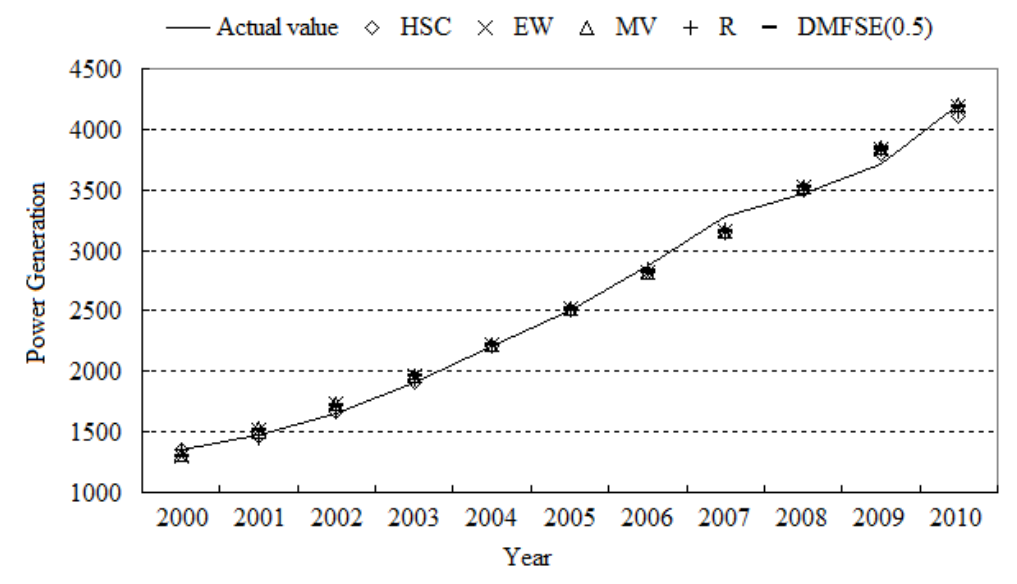
Figure 6. Forecasting performance of the HS-based JPOC model and the other combination models for